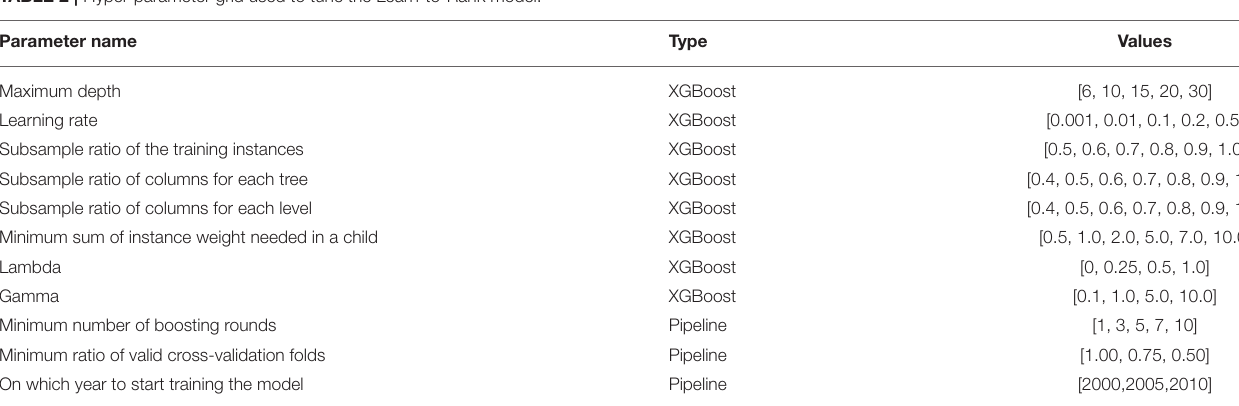
TABLE 2 | Hyper-parameter grid used to tune the Learn-to-Rank